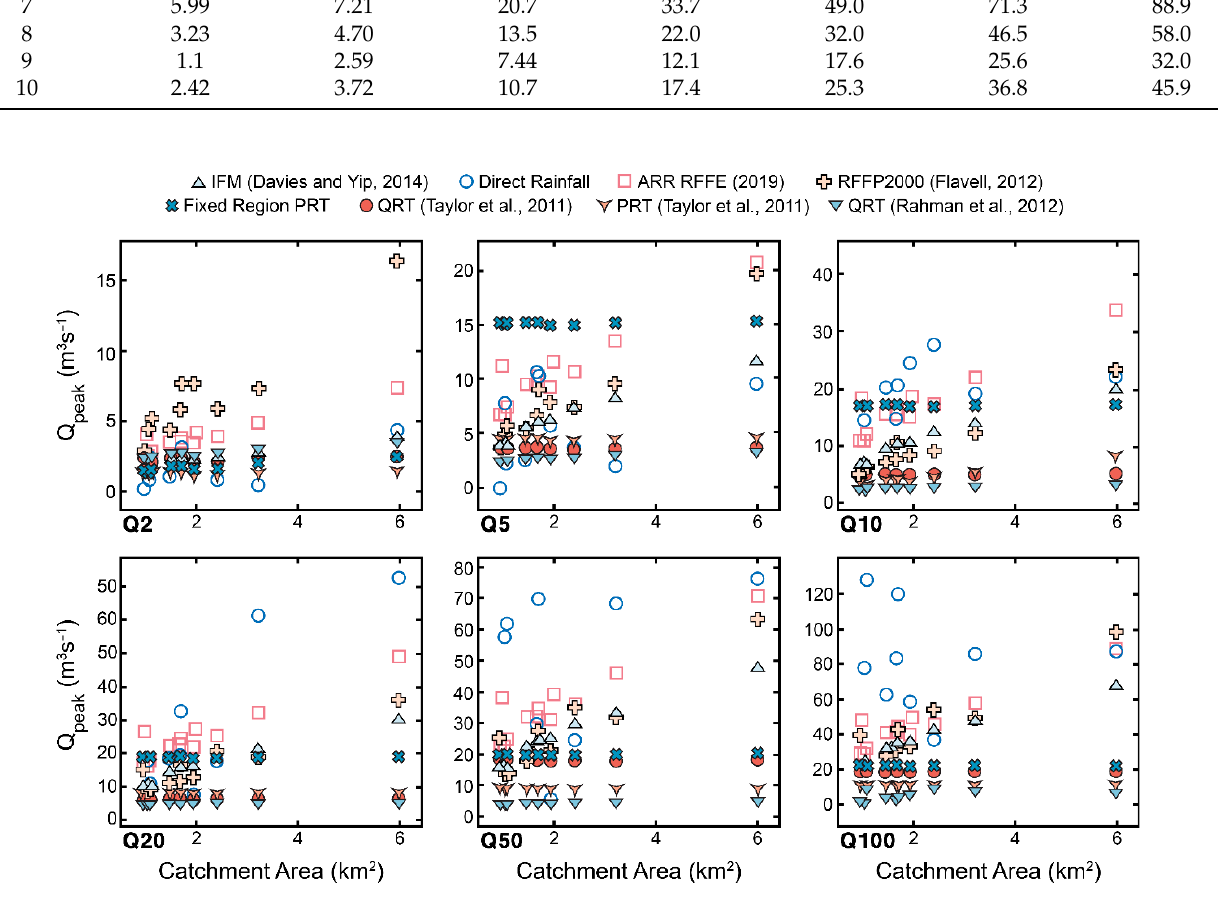
Figure 9. Comparison of small flood predicted peak discharges using RFFE approaches [2,15,17,18] for Q 2 , Q 5 , Q 10 , Q 20 , Q 50 and Q 100 return intervals. Table 4. Modelled peak discharges using the direct rainfall modelling approach for a 12 h rainfall event across average return intervals. Peak discharge values are in m 3 s − 1 .